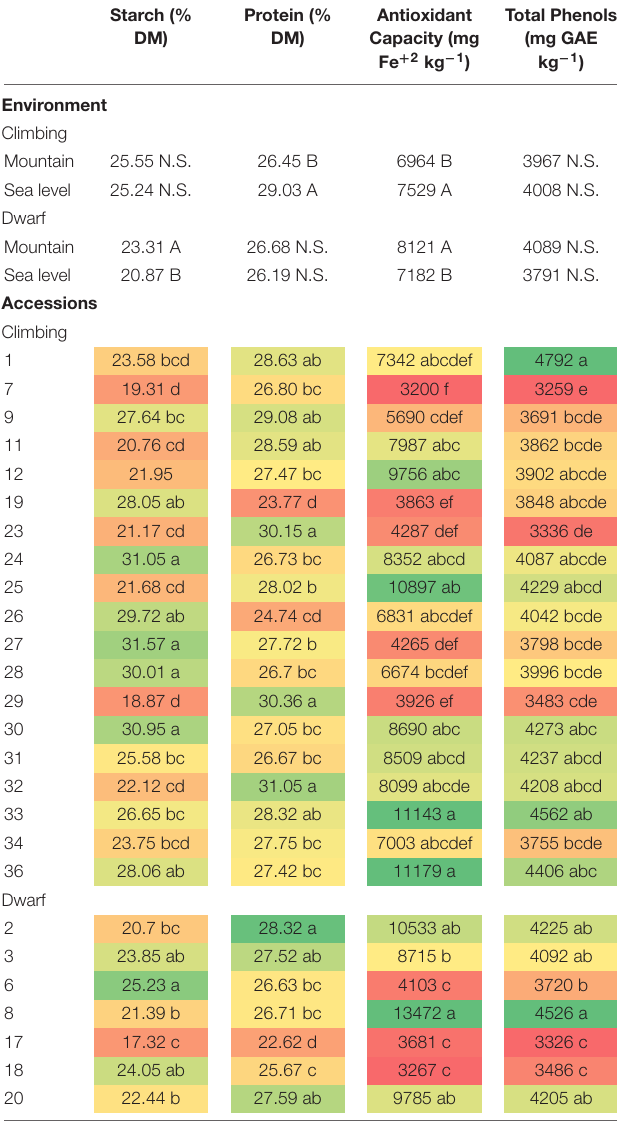
Different uppercase letters indicate a significant difference between environments. N.S., non-significant environmental effect. Different lowercase letters in the same column indicate a significant difference between compared accessions. α =